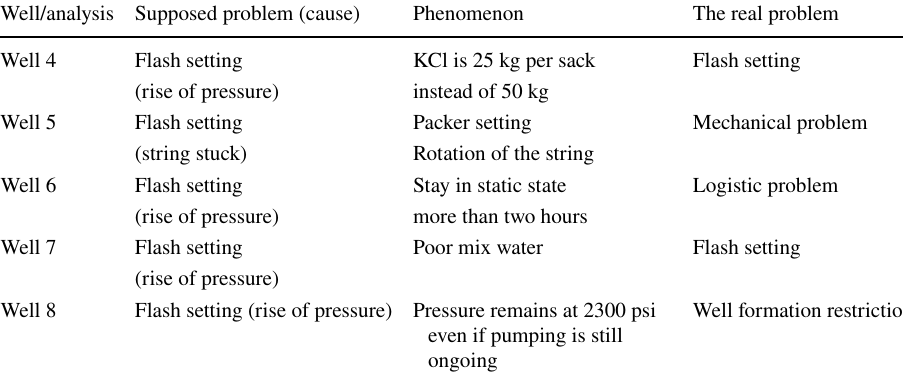
Table 3 HPABM-Cheese